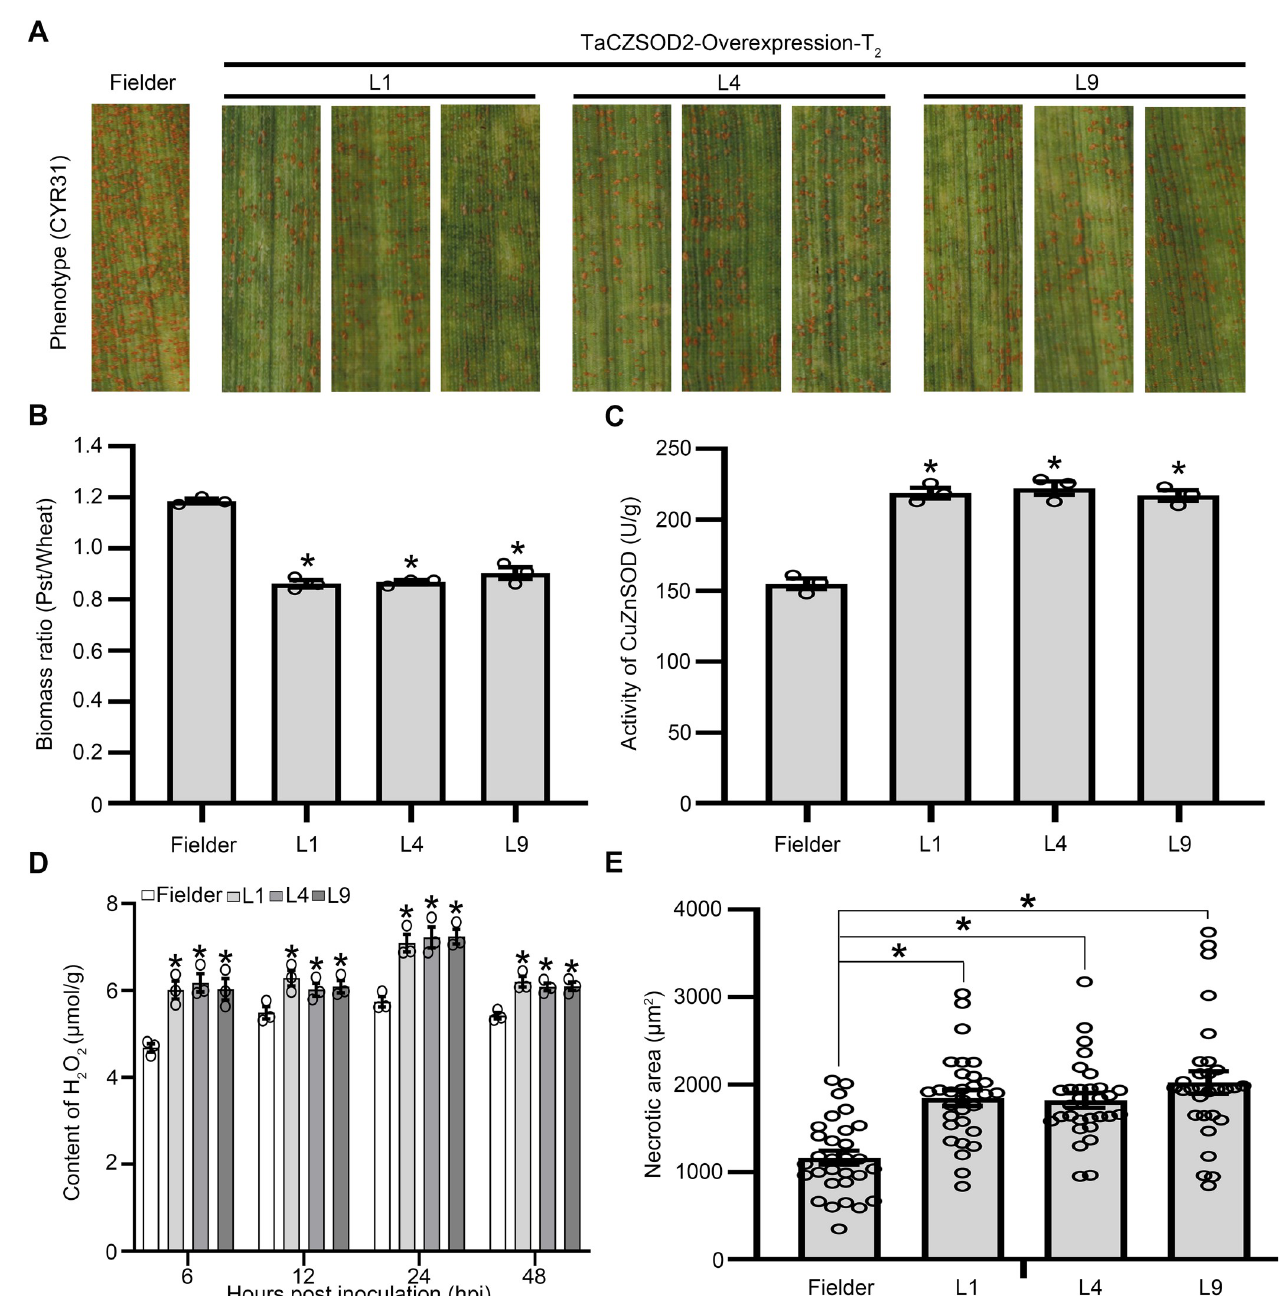
Fig 5. Overexpression of TaCZSOD2 significantly increases H 2 O 2 accumulation and confers the resistance of wheat to Pst . (A) Phenotypes of the third leaves of the second generation of wheat plants at 14 dpi with Pst . (B) Ratio of fungal to wheat nuclear content determined using the contents of fungal PstEF1 and wheat TaEF-1 α genes, respectively. Genomic DNA was extracted from the second leaf from three different plants at 14 dpi. Values represent the means ± SE (n = 3). (C) The enzyme activity of CuZnSOD in TaCZSOD2 -overexpression plants at 48 hpi with Pst . Values represent the means ± SE of three independent samples. (D) Content of H 2 O 2 in different transgenic lines at 6, 12, 24 and 48 hpi. Values represent the means ± SE of three independent samples. (E) Quantification of necrotic cell death area in different transgenic lines at 72 hpi. Values represent the means ± SE (n = 30). Differences were assessed using Student’s t -test. Asterisk indicates P <